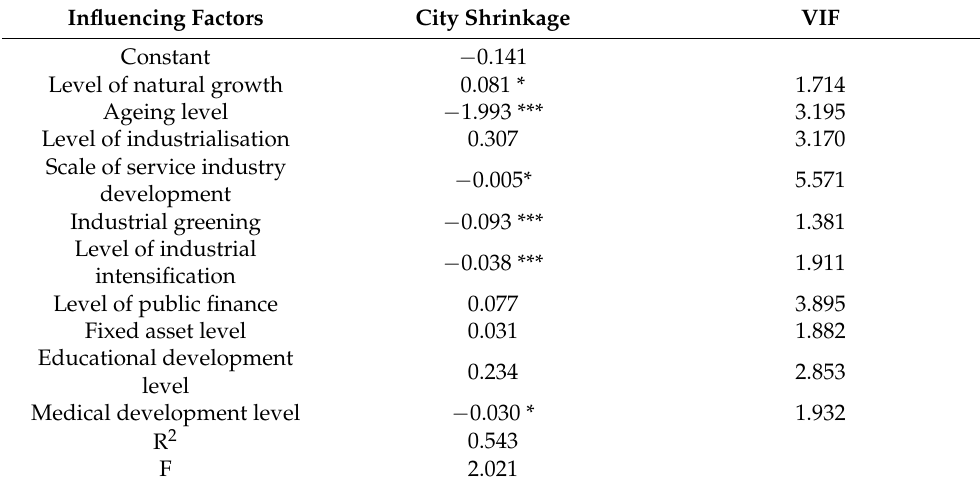
Table 5. OLS regression results of factors influencing urban shrinkage in the Yellow River Basin. Influencing Factors City Shrinkage VIF Constant − 0.141 Level of natural growth 0.081